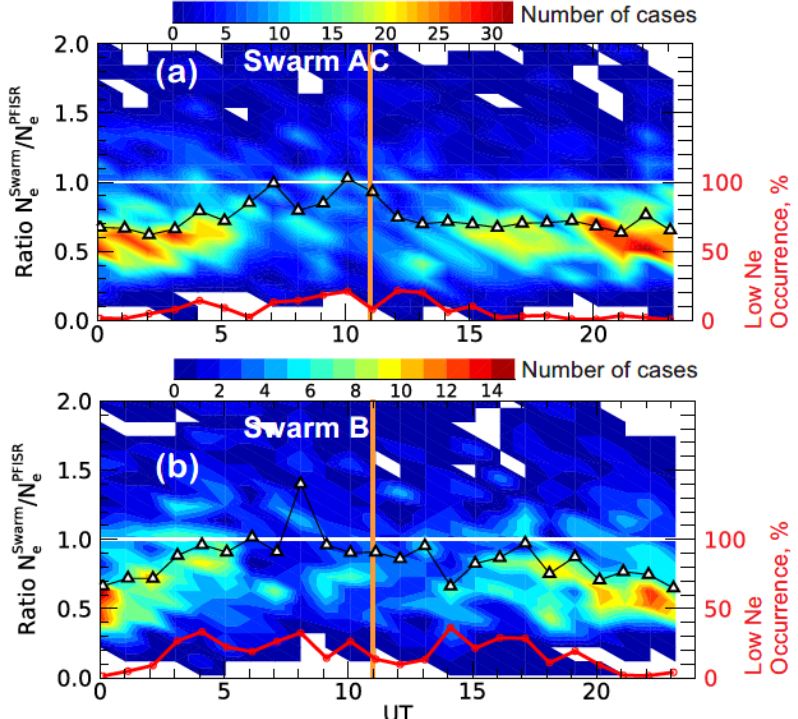
Figure 8. ( a ) A scatter plot for the occurrence of ratio R = N eSwarm /N ePFISR for Swarm AC versus UT time of radar–satellite conjunctions. The scale for R is represented by the bar at the top. The overlaid black ‐ white triangles are hourly median R values. The overlaid red line is the occurrence of low electron densities with N ePFISR < 3 × 10 10 m − 3 , given in percent of the total number of measurements for each one ‐ hour bin. The vertical beige line denotes local midnight. The scale for the occurrence is shown on the right (y) axis. ( b ) The same as ( a ) but for the PFISR ‐ Swarm B conjunctions.